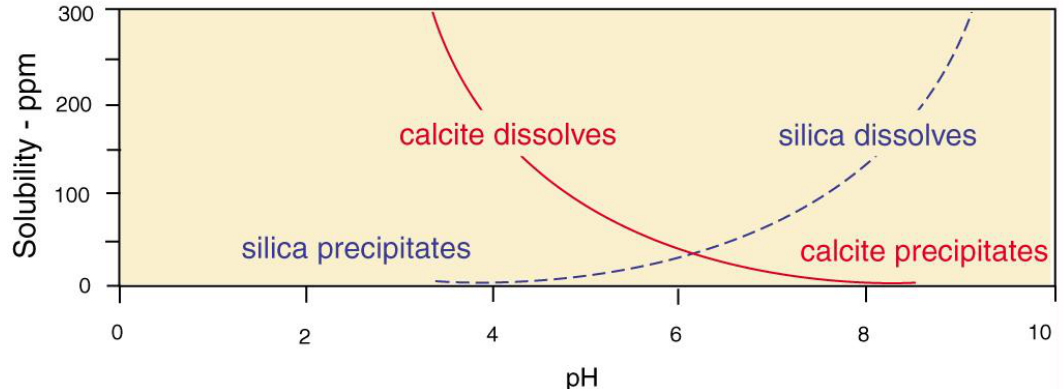
Figure 32. Solubility of calcite and silica at 25˚C. Data adapted from [81,82].